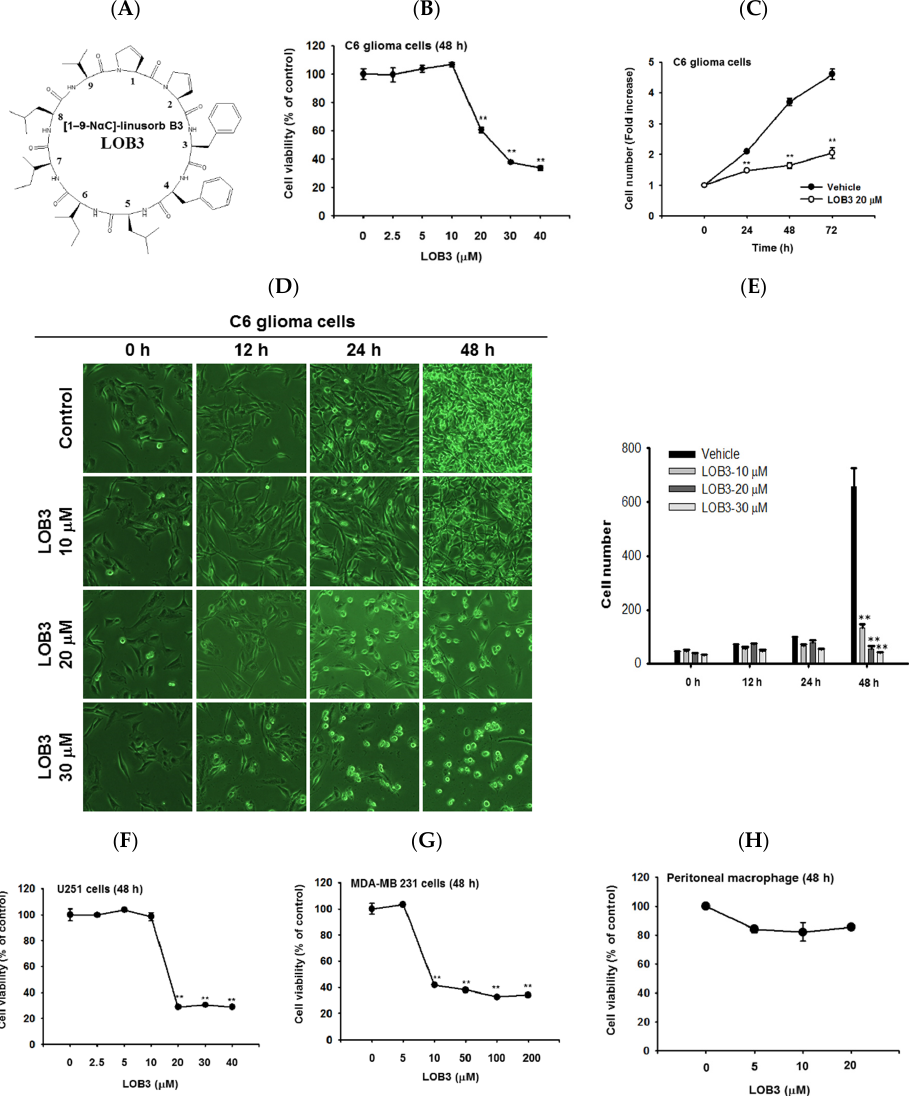
Figure 1. Cytotoxic and anti-proliferative effect of LOB3 in cancer cells. ( A ) Chemical structure of LOB3. ( B ) C6 cells were treated with the indicated doses of LOB3 for 48 h, and cell viability was determined